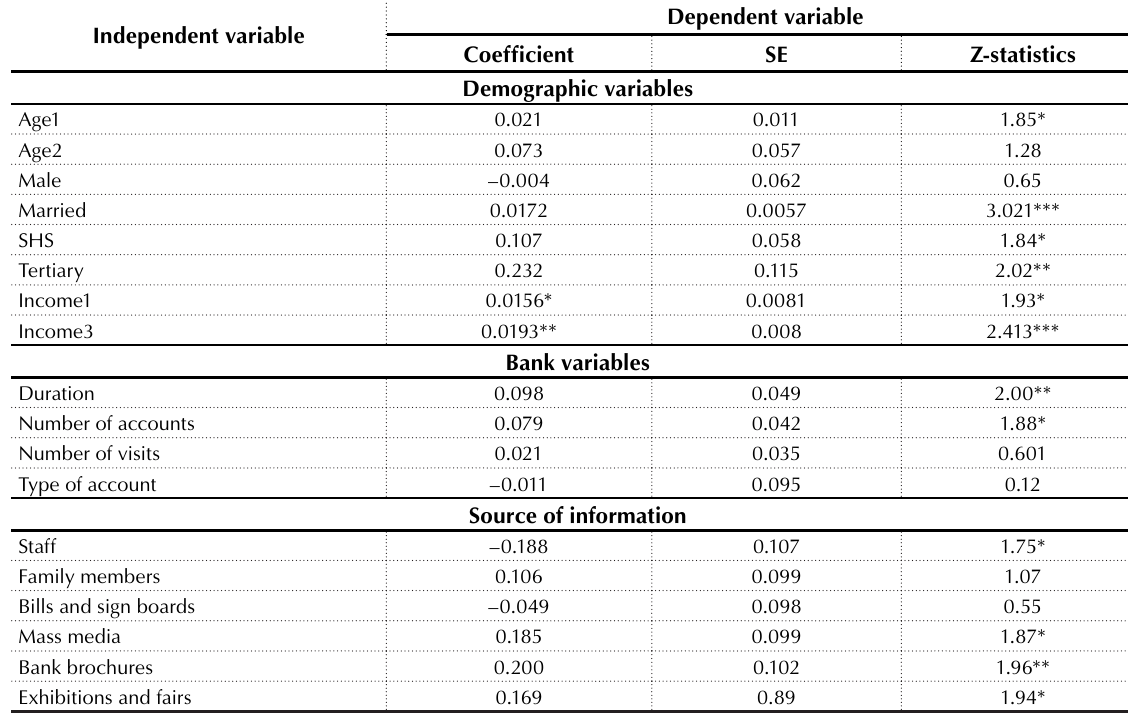
Table 4. Point estimates of the parameters of ordered probit